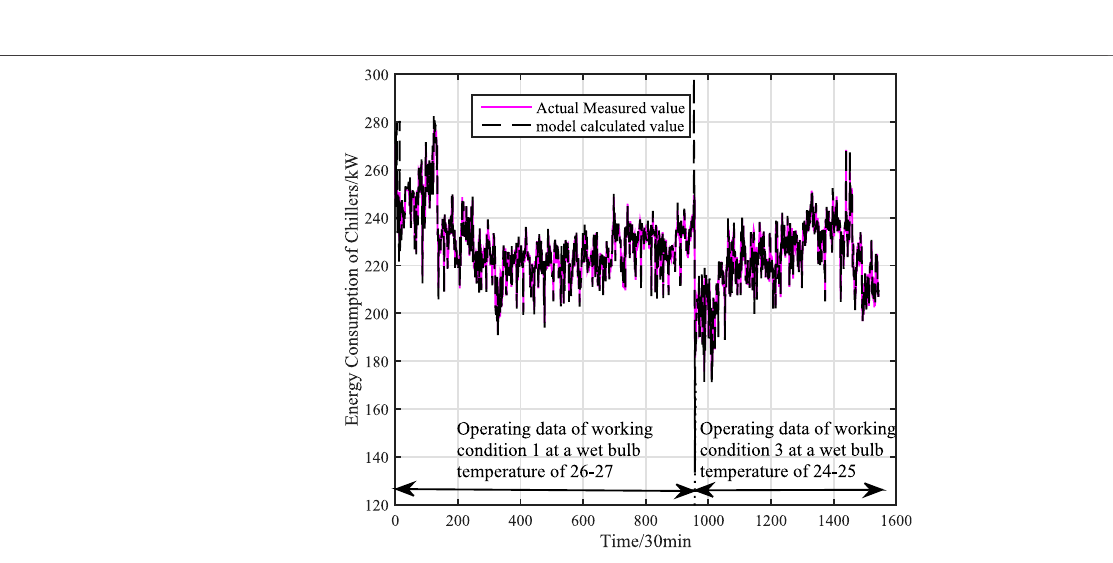
Frontiers in Energy Research |